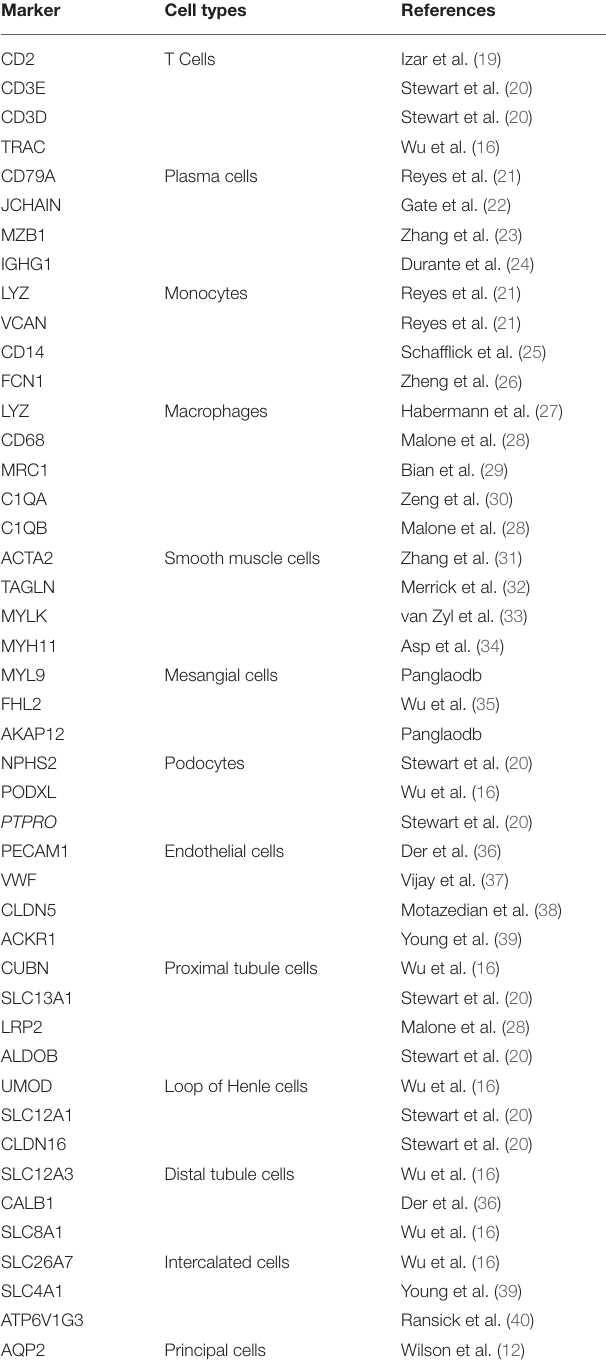
TABLE 1 | Markers for different cell types based on their cell